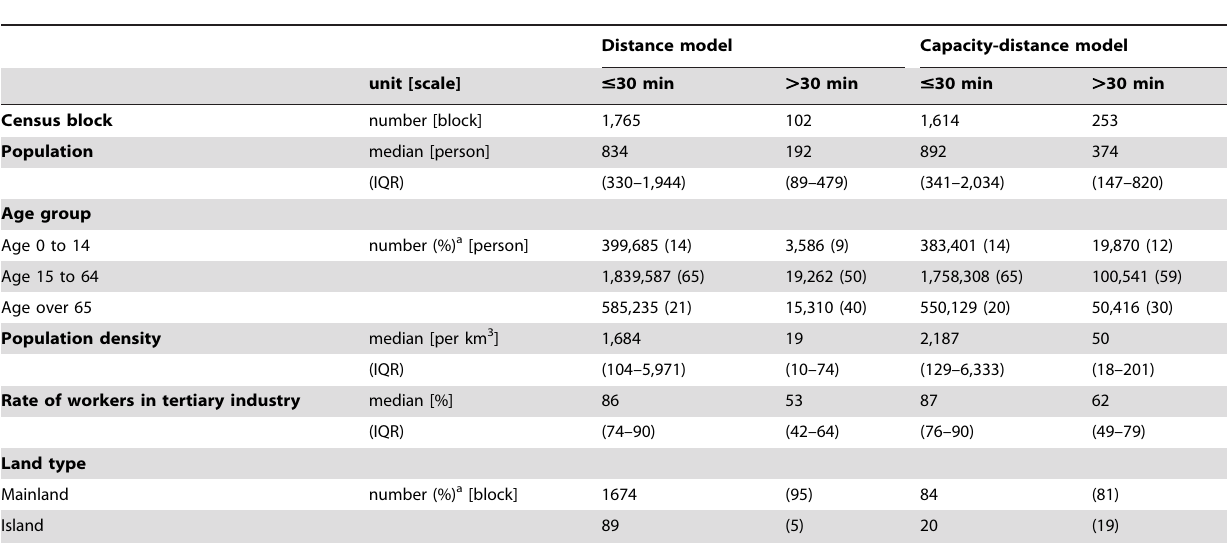
Table 1. Demographic, social and environmental characteristics of 1,867 census blocks classified according to travel time to the closest dialysis facility in 2011 in Hiroshima,